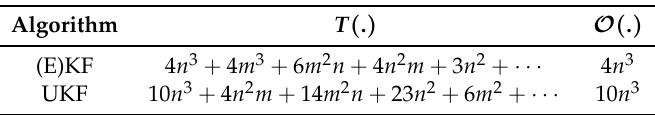
Table 5. Kalman filters